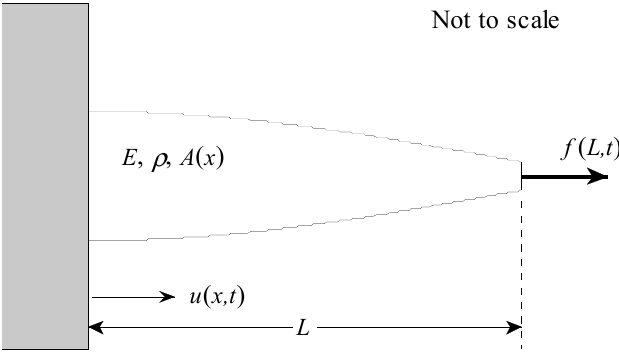
Figure 7. Fixed-free rod with a first kind, zero order Bessel function change of area.